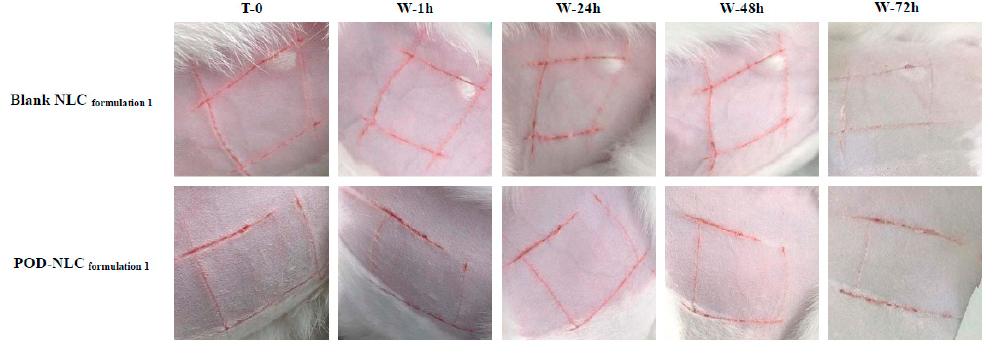
Figure 7. Images of damaged rabbit skin before and after the single ‐ time topical administration of POD ‐ NLC formulation 1 or blank NLC formulation 1 . Notes: T 0 represents immediately before the